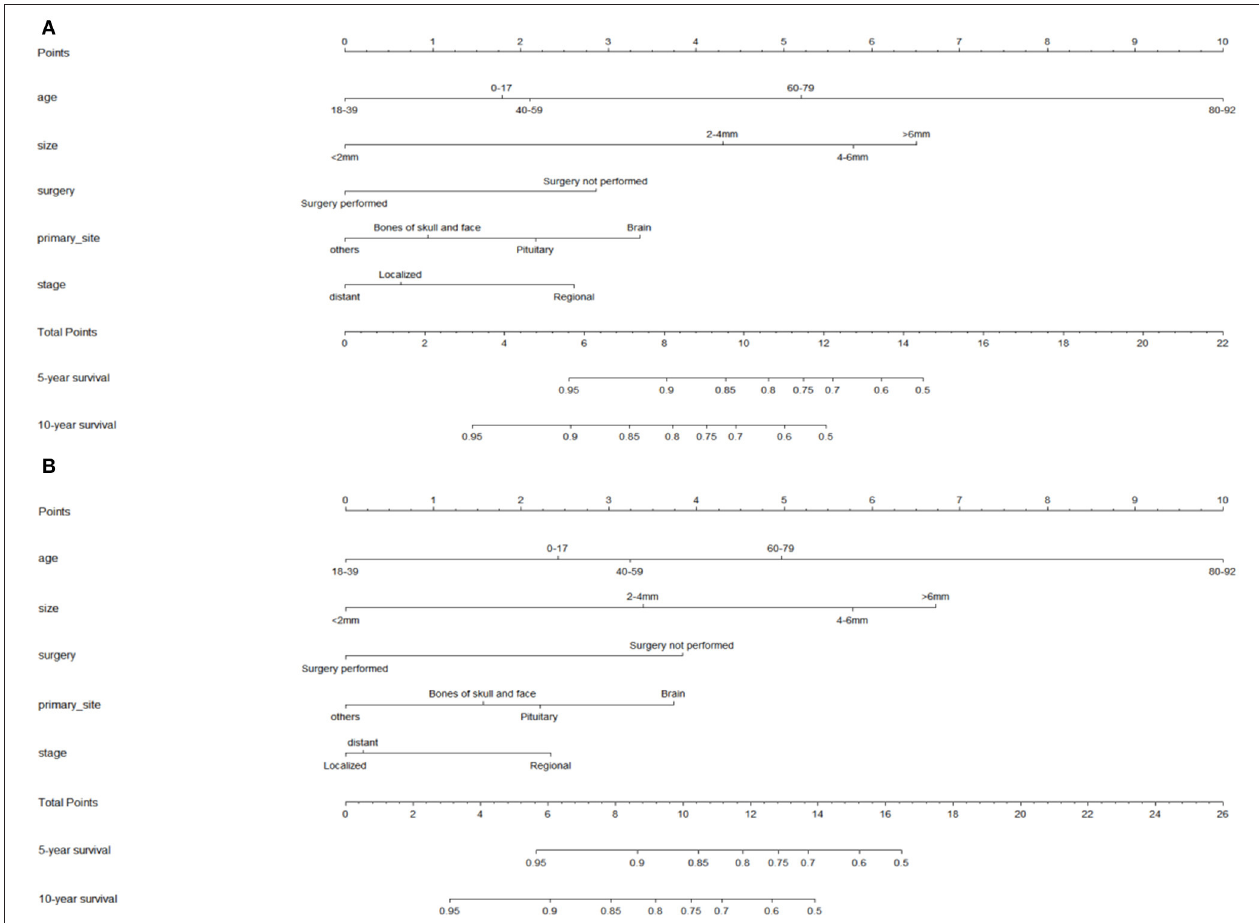
FIGURE 3 | Nomograms for predicting the 5- and 10-year overall survival (A) and disease-specific survival (DSS) (B) of skull base chordoma patients. OS index of concordance (C-index): 0.764, DSS C-index: 0.755.